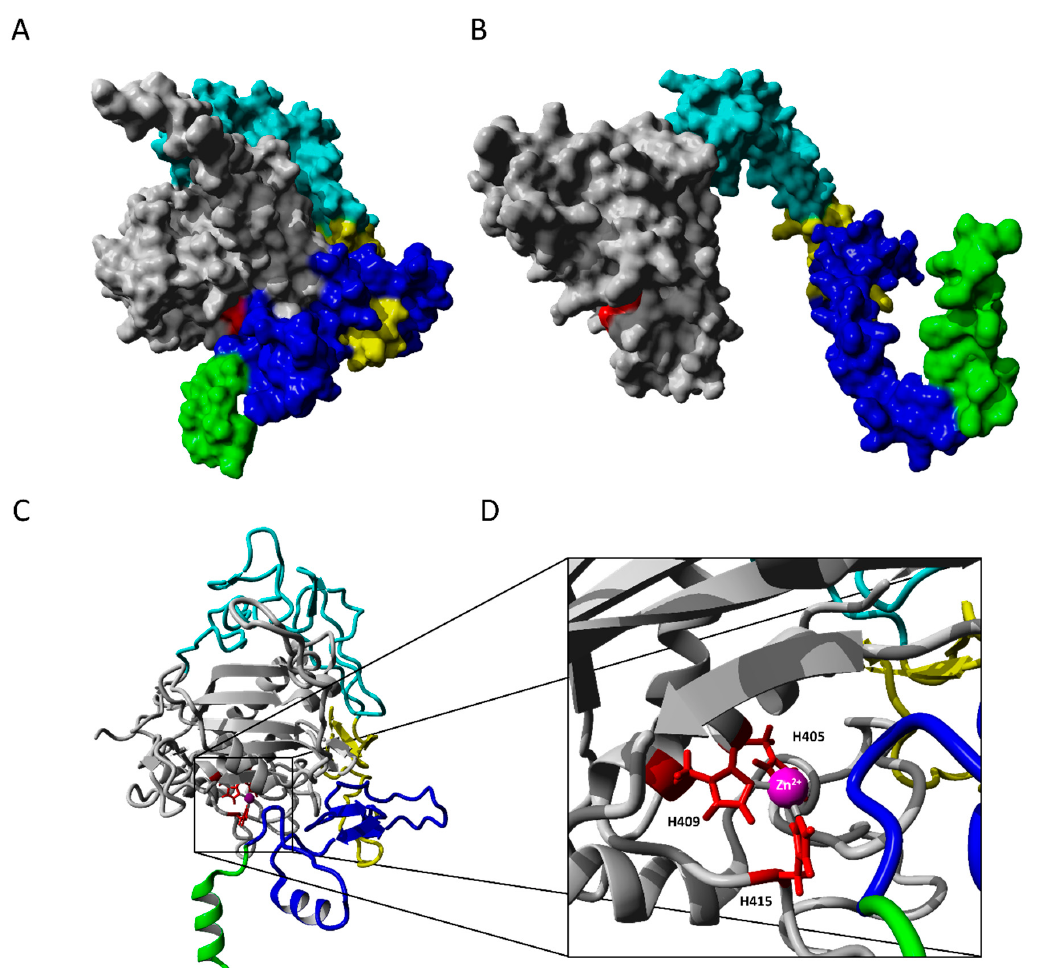
Figure 3. Structural model of extracellular domain of ADAM17 (R215-W684). Molecular surface representation and colored subdomains of hybrid model predicted by YASARA ( A ), and extracellular domain model based on AlphaFold Protein Structure Database ( B ); For the extracellular domain of ADAM17 from AlphaFold the full-length ADAM17 model (P78536) was extracted from AlphaFold Protein Structure Database and the intracellular region, the propeptide, and the signal peptide were deleted in YASARA ( C ). Ribbon model with folded linker arm, divided into subdomains (transmembrane: green, membrane-proximal domain: blue, cys-rich: yellow, disintegrin: cyan, metalloprotease: grey); ( D ) A close-up stereo view of the active site taken from ( C ): Zinc ion, bound by His 405, 409 and 415 (red), is marked in magenta.